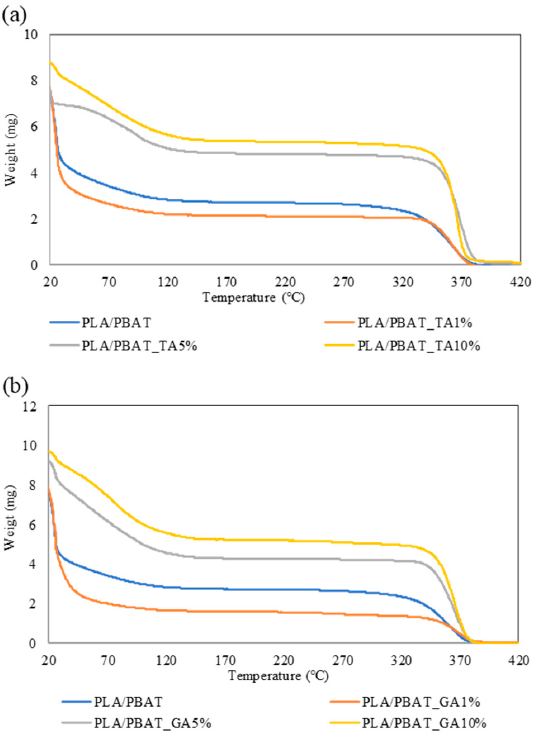
Figure 3. TGA of ( a ) Tannic acid (TA) incorporated PLA/PBAT film, ( b ) Gallic acid (GA) incorporated PLA/PBAT film.